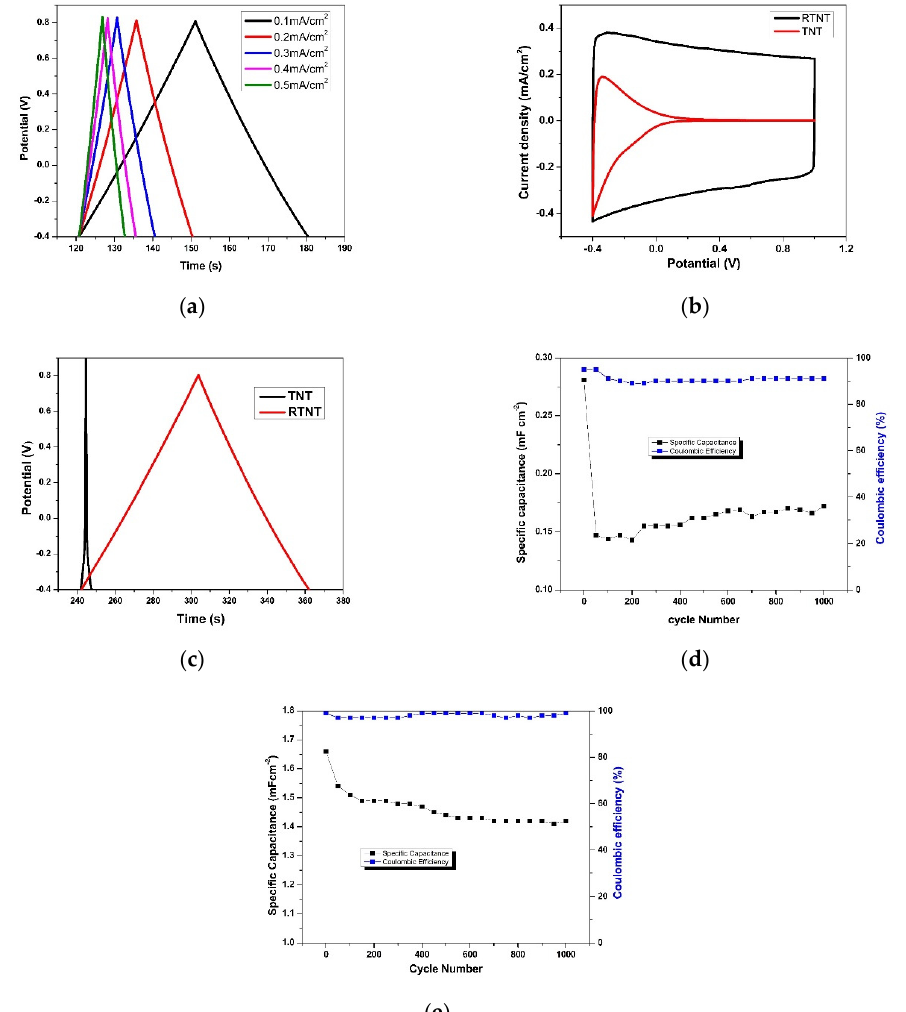
Figure 9. ( a ) GCD curves of R-TNTs at di ff erent current densities. Comparison of CV voltammograms ( b ) and GCD curves ( c ) of pristine TNTs and R-TNTs at a scan rate of 200 mV s − 1 and at current density of 0.02 mA cm − 2 . Specific capacitance and coulombic e ffi ciency versus number of cycles for ( d ) pristine TNTs at 0.02 mA cm − 2 and ( e ) R-TNTs at 0.2 mA cm − 2 current